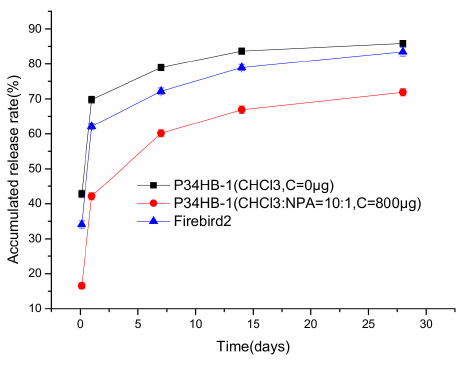
Figure 10. Drug release profiles of P34HB-1 (both mixed solvents and double layers) and Firebird2 ®